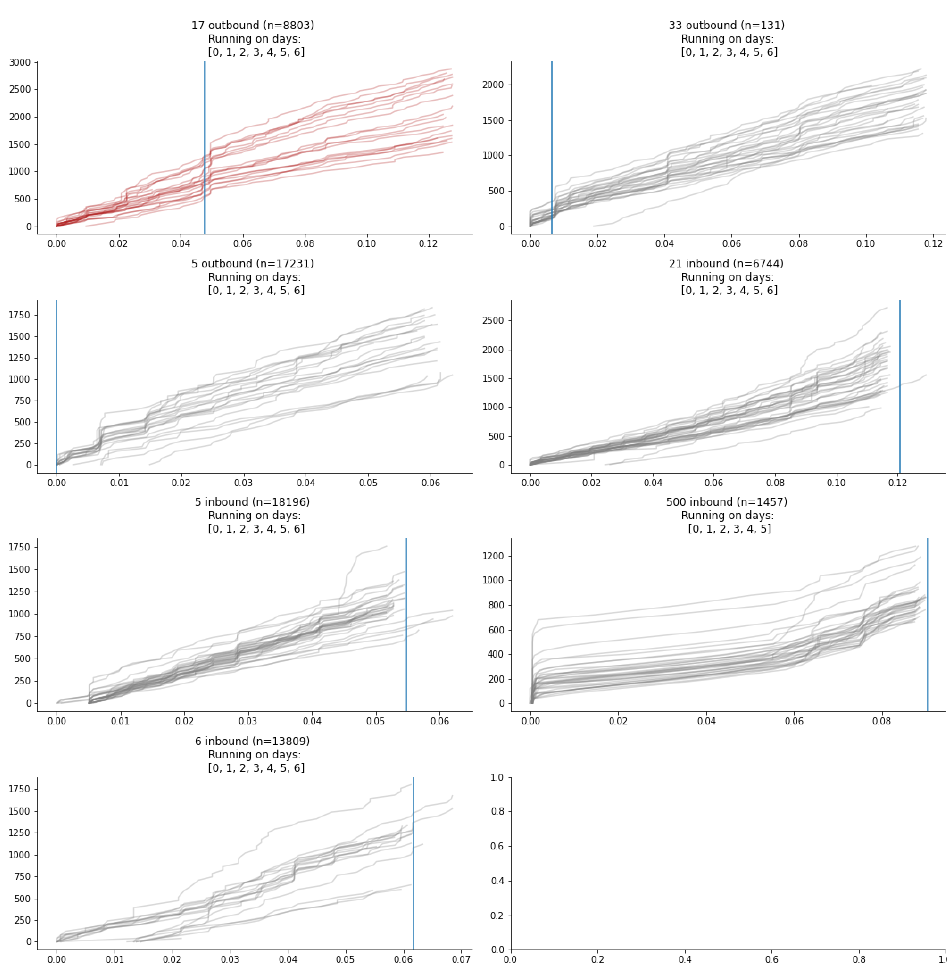
Figure 4. Interacting line trajectories blue line is the are of interaction from Figure 2, red trajectories are the line of interest in this case line 17